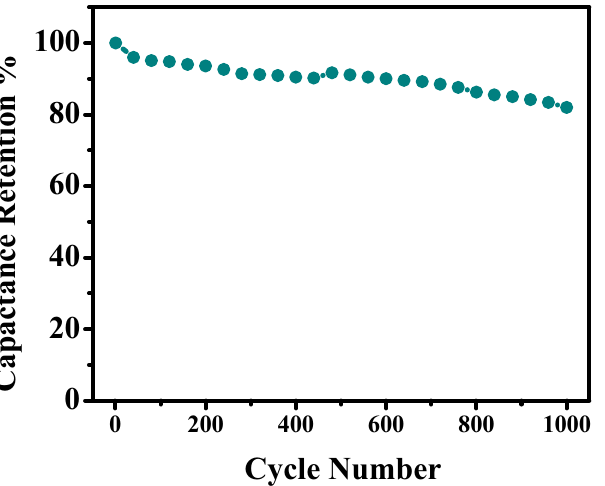
Figure 9. Cycling stability of the P3HT/50% SWCNT nanocomposite supercapacitor electrode at 1 A g −1 for 1000 GCD cycles.